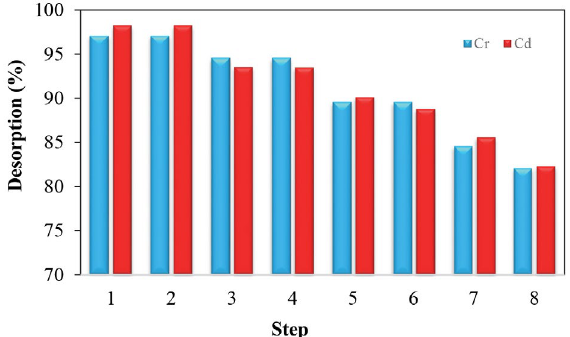
Fig. 10: Desorption of cadmium (II) and chromium (III) ions from solution using acetone/ethanol